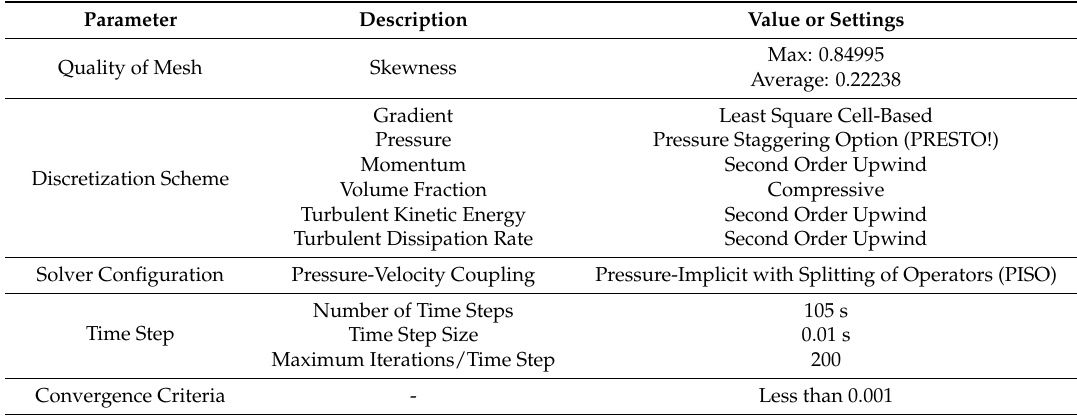
Table 3. CFD Setting for the